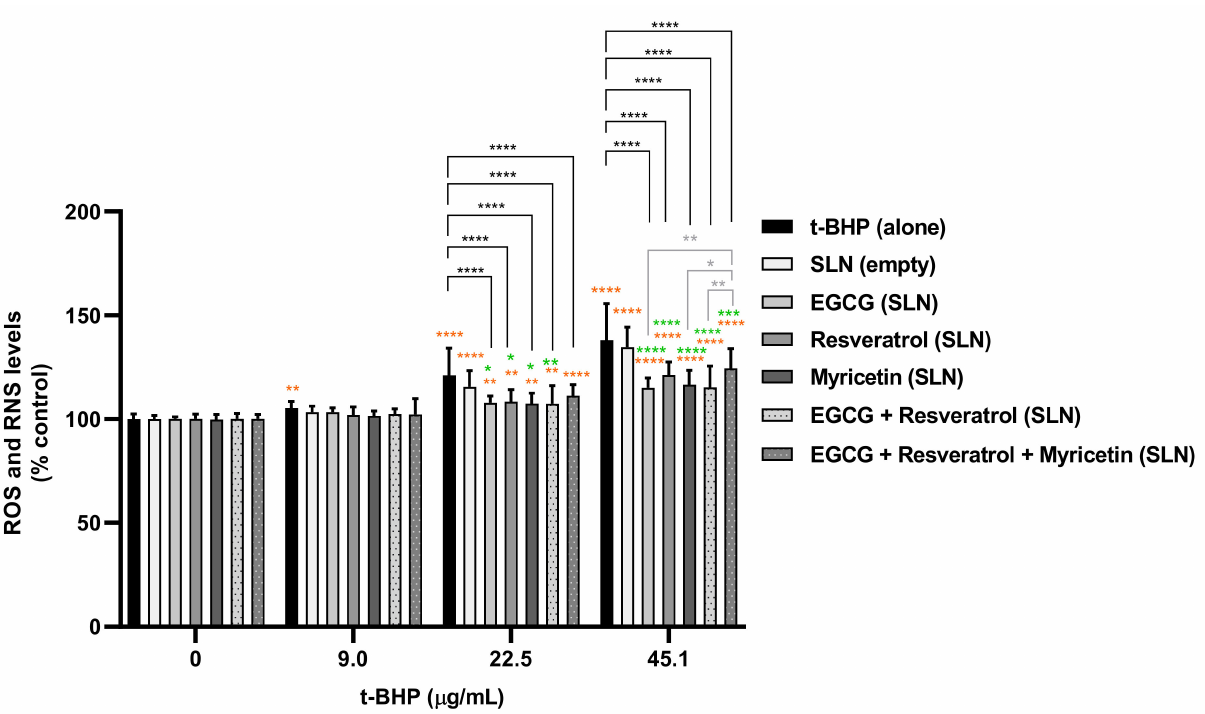
Figure 7. Intracellular levels of ROS/RNS evaluated in HaCaT cells 6 h after exposure to t-BHP (0–45.1 µ g/mL) in the presence or absence of the developed SLN formulations. Results are expressed as mean ± SD from six independent experiments performed in triplicate. Statistical comparisons were made using two-way ANOVA followed by Tukey’s multiple comparisons test (* p < 0.05, ** p < 0.01, *** p < 0.001; **** p < 0.0001; orange represents the statistical analysis for each condition versus 0 µ M t- BHP; green represents the statistical analysis at each t-BHP concentration for the comparison between NC-loaded SLN formulations and the unloaded SLN formulation; black represents the statistical analysis at each t-BHP concentration for the comparison between each SLN formulation and t-BHP alone; grey represents the statistical analysis at each t-BHP concentration for the comparison between the different NC-loaded SLN formulations). In all cases, p -values < 0.05 were considered